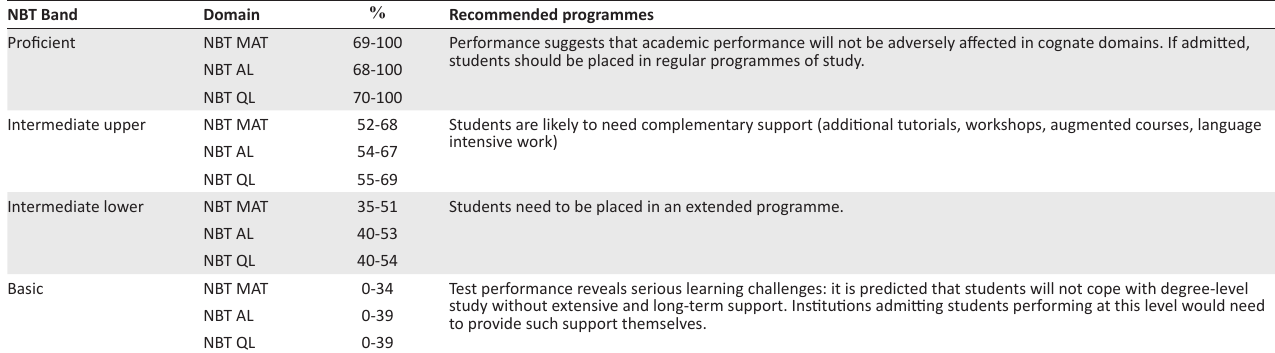
TABLE 1: Proficiency standards for academic, quantitative literacy and mathematics (Centre for Educational Testing for Access and Placement). NBT